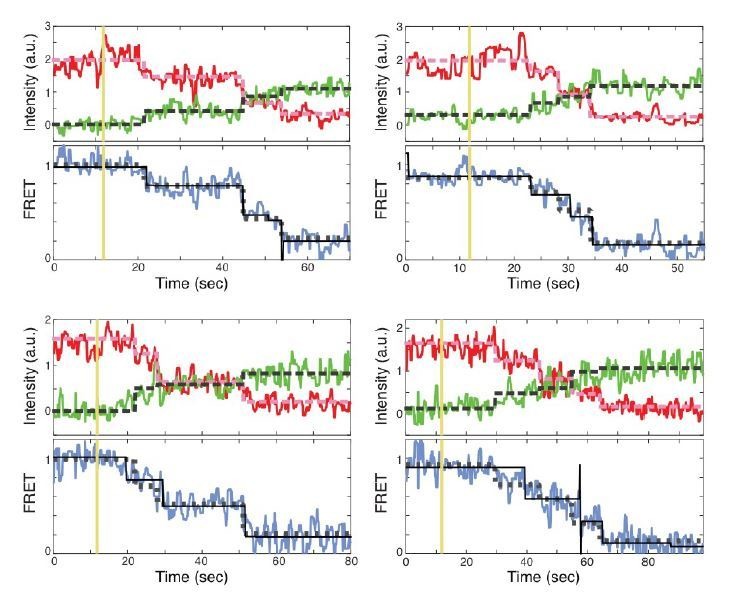
Comparison of the fit obtained by our HMM algorithm (pyhsmm) to that obtained by the Kerssemakers algorithm.Cy5 intensities (red data), Cy3 intensities (green data), and FRET values (blue data) are shown for 4 of the example traces in Figure 3 and Figure 3—figure supplement 5. Data are plotted as in those figures (including a 0.95-second smoothing filter, for visualization only). Dashed red and green lines in top panels show fits generated by pyhsmm to the Cy3 and Cy5 intensity data; dashed gray lines in the bottom panels show pyhsmm results in terms of FRET. The Kerssemakers algorithm acts only on the FRET values, so the outcome of Kerssemakers is shown on the bottom FRET panels only, as solid black lines.